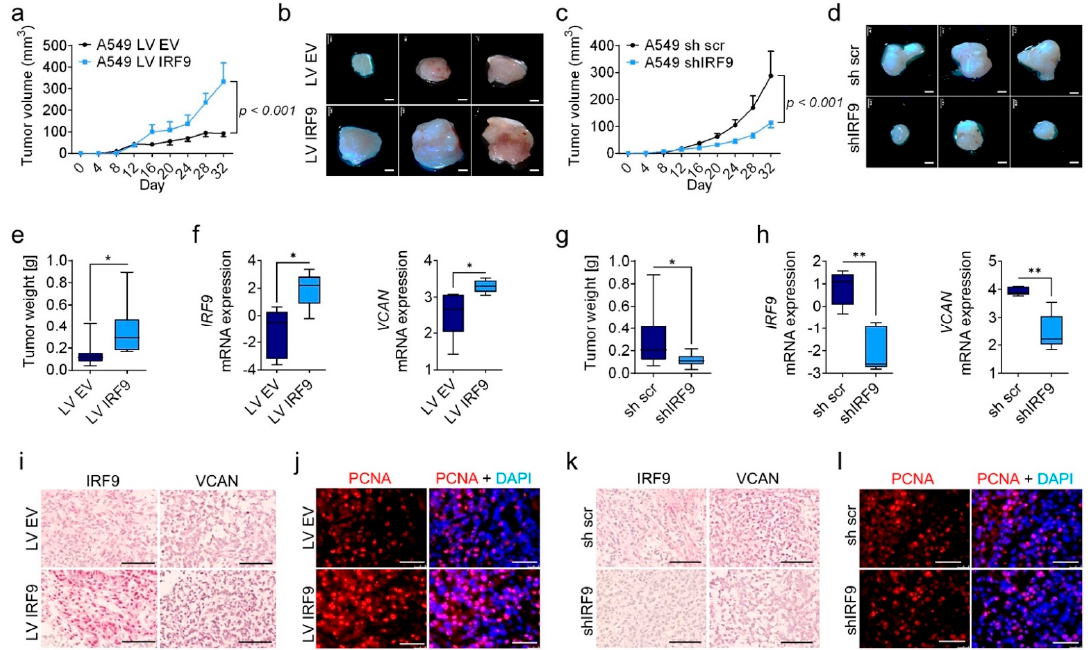
Figure 7. IRF9 overexpression and knockdown influenced tumor growth in a xenograft LUAD tumor model. A549 IRF9 transduced tumor cells were subcutaneously injected into BALB/c nude mice. ( a ) The tumor size of IRF9-overexpressing and empty vector tumors ( n = 8–10) was measured every four days using calipers. ( b , d ) Representative images of dissected tumors. Scale bar: 2 mm. ( e ) The tumor weights of dissected IRF9-overexpressing and empty vector tumors were measured at 32 days. ( f ) IRF9 and VCAN mRNA levels from IRF9-overexpressing and empty vector tumors ( n = 5). ( i ) IRF9 and VCAN representative immunohistochemistry images from IRF9-overexpressing and empty vector tumors. Scale bar: 100 µ m. ( j ) Immunofluorescence staining of PCNA from IRF9 -overexpressing and empty vector tumors. Scale bar: 50 µ m. ( c ) Tumor volume of IRF9-silenced and control tumors were measured every four days using calipers ( n = 8–10). ( d ) Representative images of dissected tumors. Scale bar: 2 mm. ( g ) Tumor weight of dissected IRF9-silenced and control tumors measured at 32 days. ( h ) IRF9 and VCAN mRNA levels from IRF9-silenced and control tumors ( n = 5). ( k ) IRF9 and VCAN representative immunohistochemistry images from IRF9-silenced and control tumors. Scale bar: 100 µ m. ( l ) Immunofluorescence staining of PCNA from IRF9-silenced and control tumors. Scale bar: 50 µ m. Data are expressed as means ± standard error of the mean. Analysis was performed using Student’s t -test: * p < 0.05, ** p <